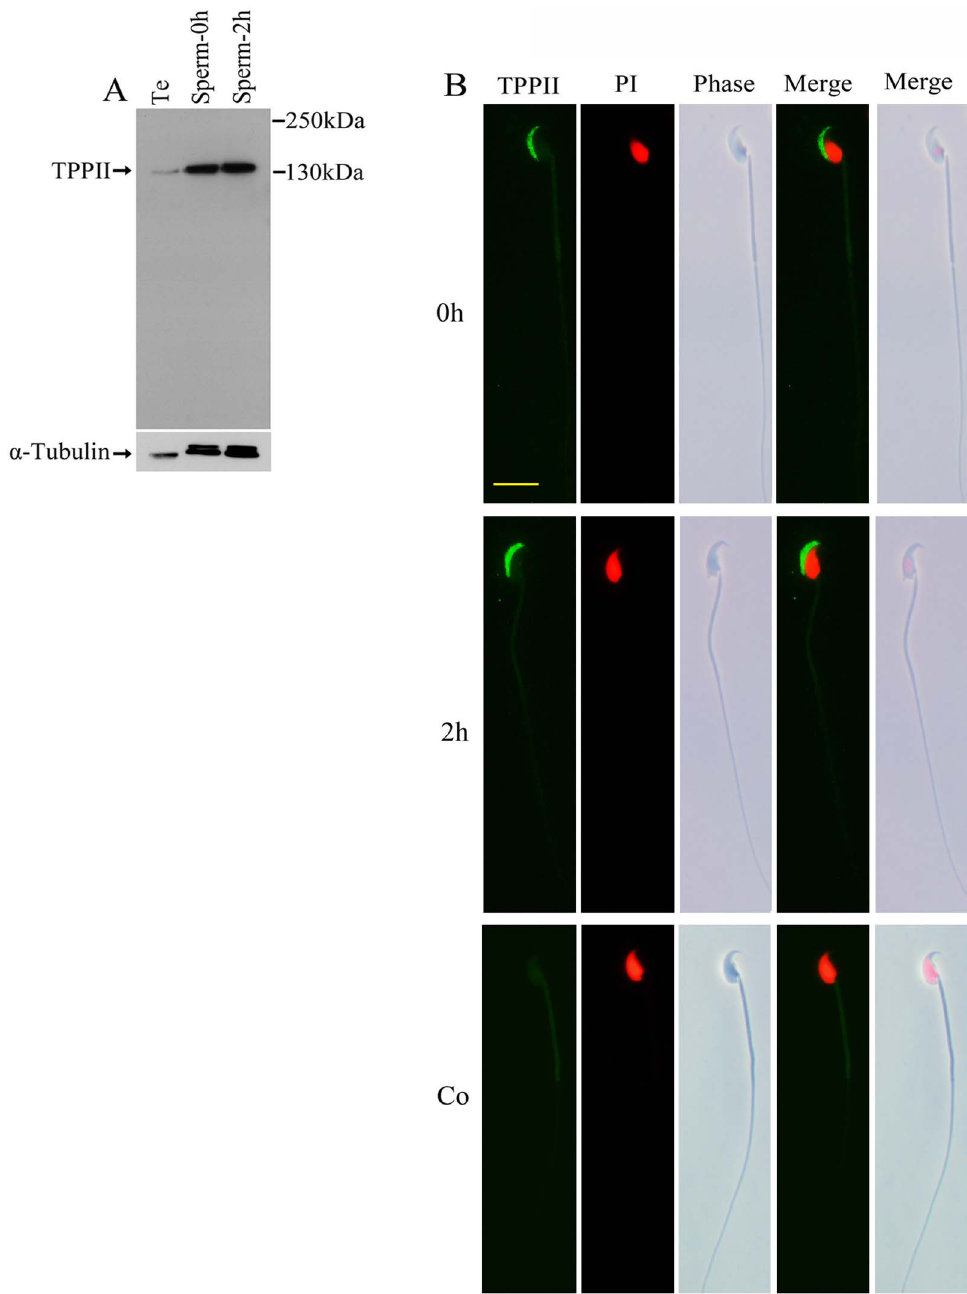
Figure 1. Characteristics of TPPII protein in mouse sperm. (A) Western blot analysis of TPPII protein in testis tissue (Te) and cauda epididymal sperm incubated in EKRB medium for 0 (Sperm-0 h) and 2 (Sperm-2 h) h. The blot was probed with monoclonal antibodies against a -tubulin to assess protein loading. The Western blot is a representative of three independent experiments. (B) Immunofluorescence staining of TPPII protein on spermatozoa. Cauda sperm before (0 h) and after (2 h) capacitation were probed with anti-TPPII polyclonal antibodies. Control sperm (Co) were examined by anti-TPPII polyclonal antibodies which were pre-incubated with the corresponding antigen peptide. Sperm DNA was stained with propidium iodide (PI) and can be seen in red. (bars 10 m m). A representative of three independent experiments is shown.